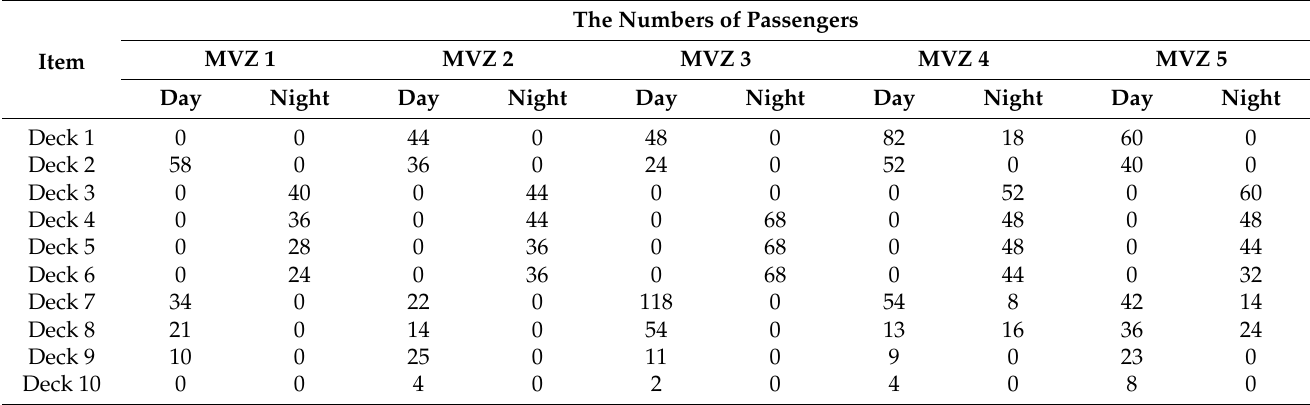
Table 1. The initial positions of passengers in the day and night